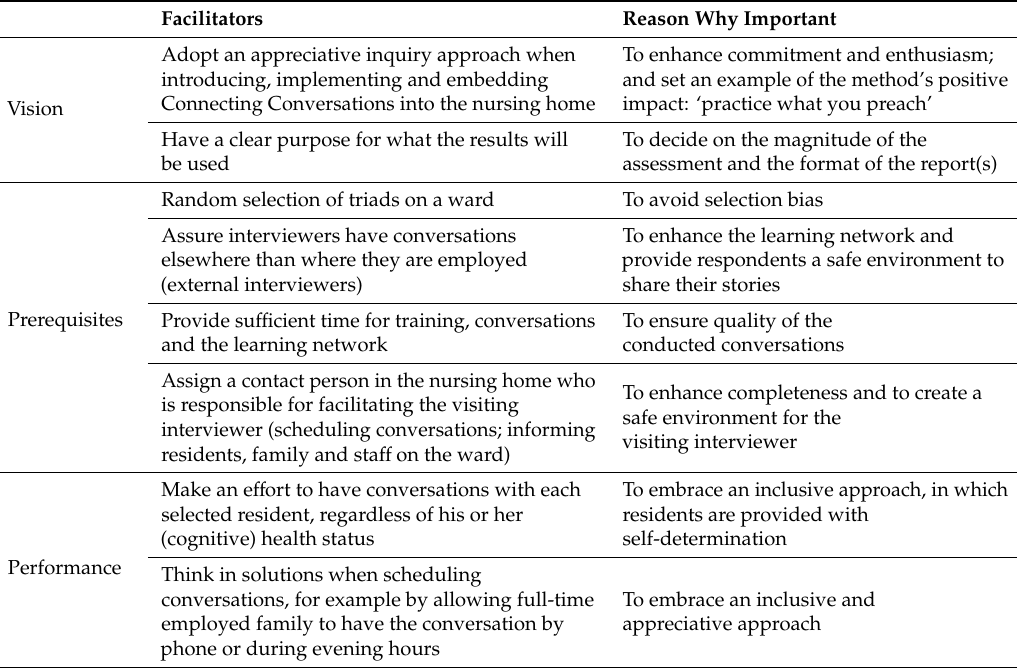
Table 5. Facilitators to implement Connecting